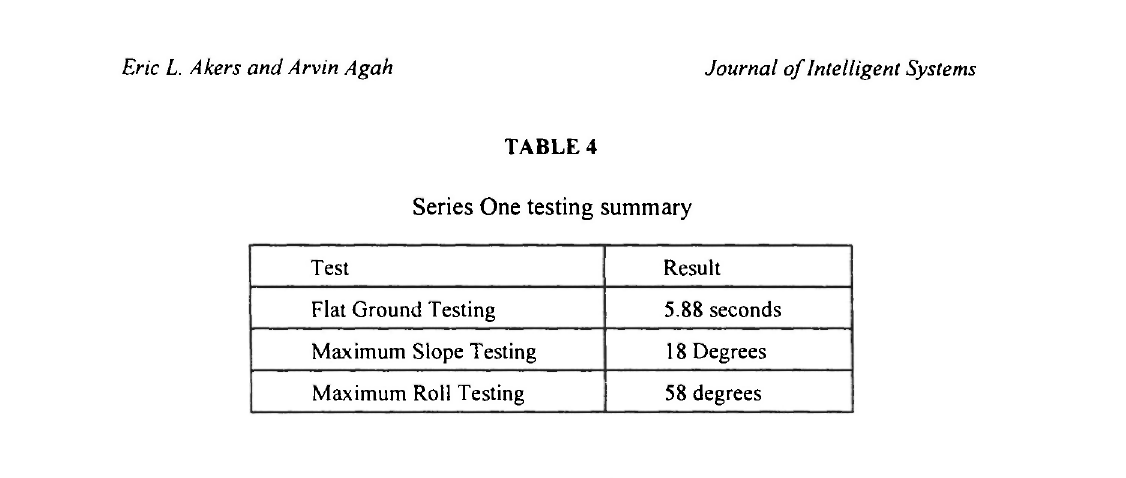
Series One testing